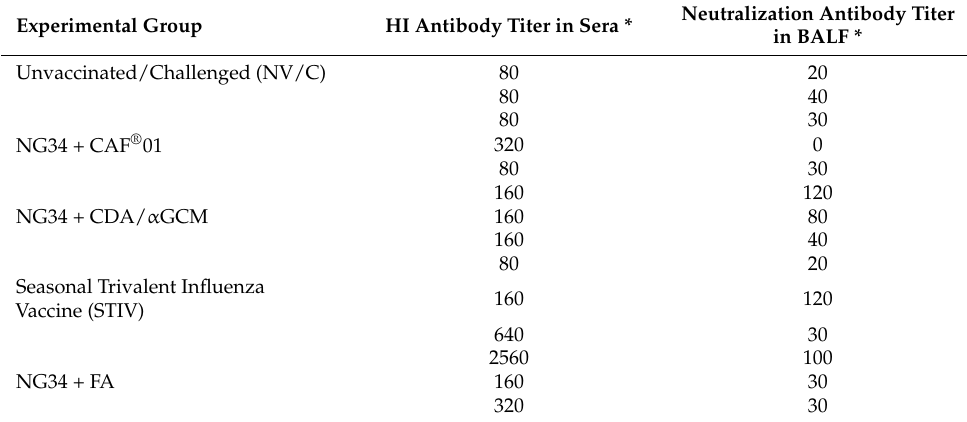
Table 3. HI titers in sera and neutralization in BALF from individual animals euthanized at 7 dpi (3 animals in each group except for the NG34 + FA group, with 2